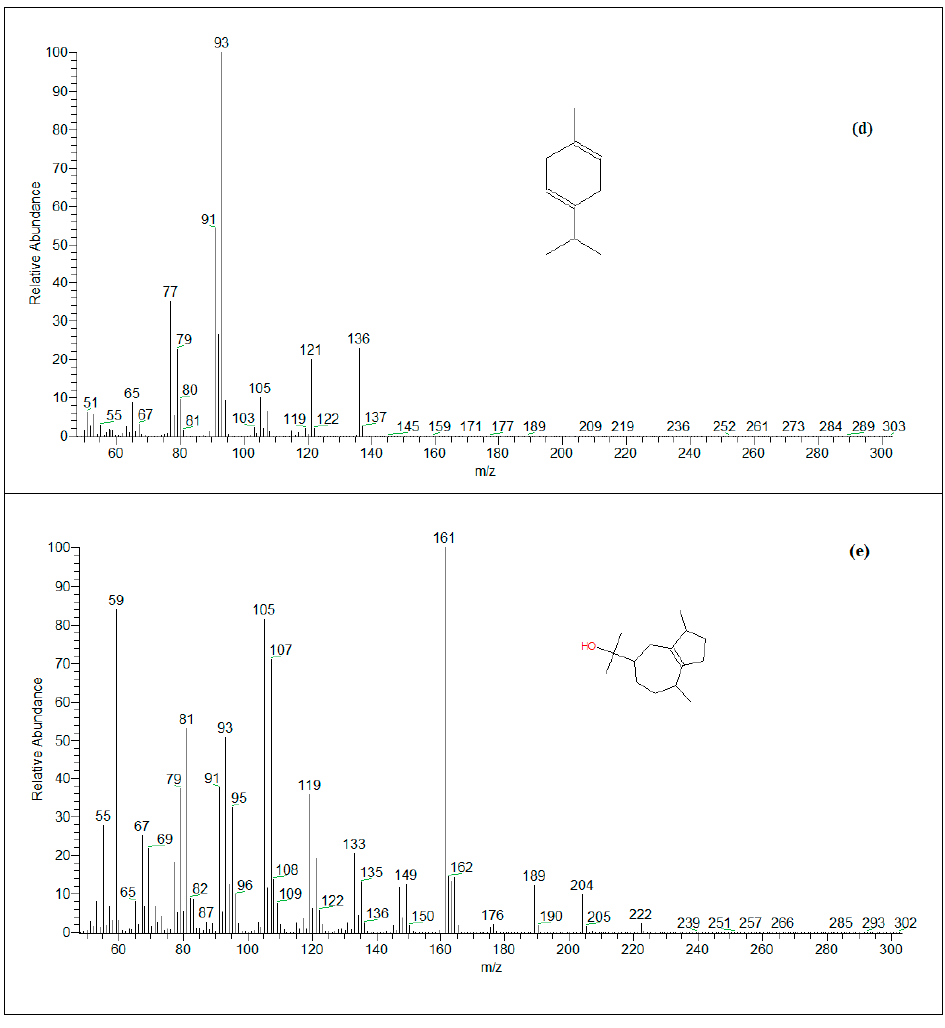
Figure 3. The 70 eV mass spectrum of ( a ) α -pinene ( b ) eudesmol ( c ) limonene, ( d ) γ -terpinene and ( e ) guaiol in C. citriodora unripe fruits’ essential oil. M stands for mass and Z stands for charge number of